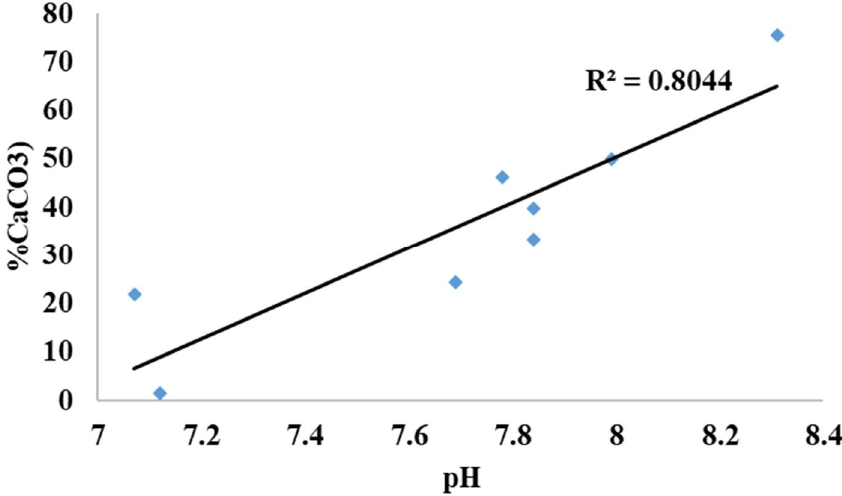
Figure 3. Relationship between soil pH and CaCO 3 concentrations in the studied soils.